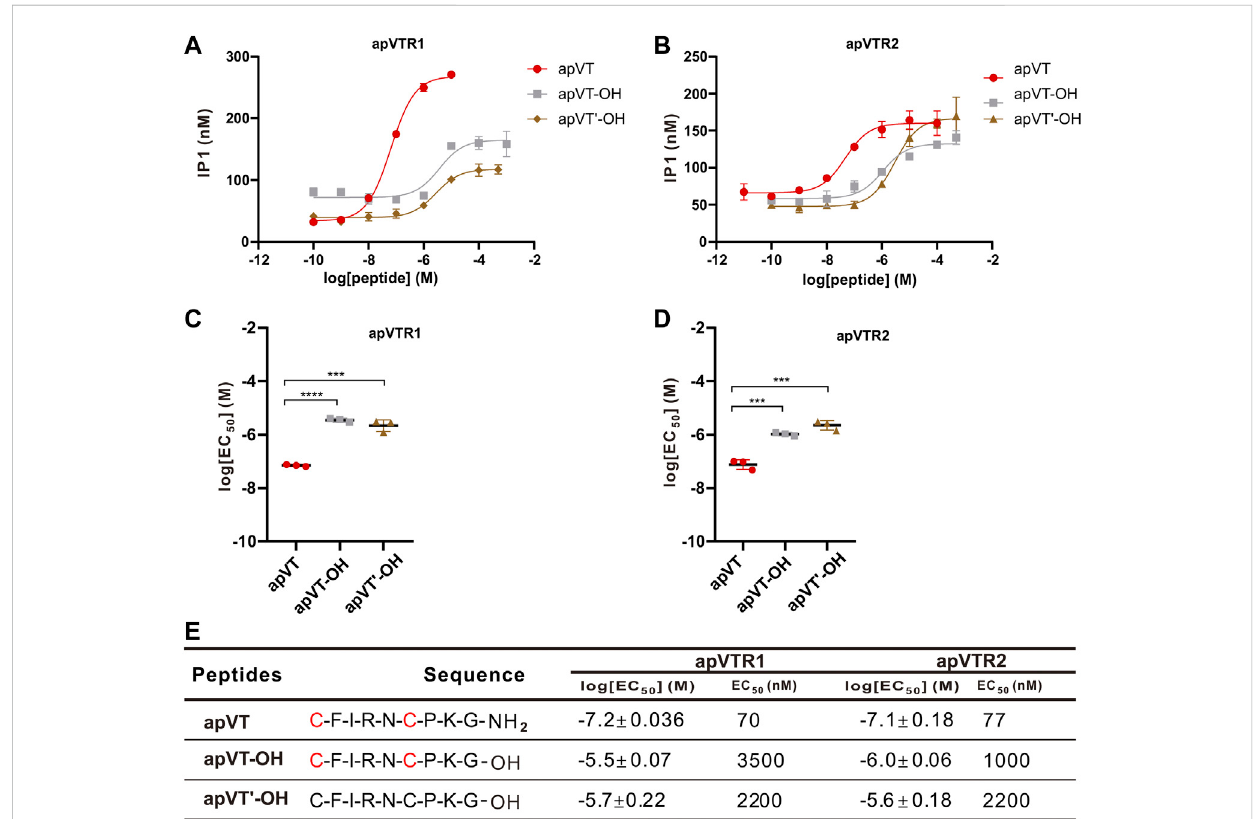
Activation of apVTRs by apVT analogs without the C-terminal amidation. (A) Representative examples of activation of apVTR1 by apVT analogs without the C-terminal amidation: apVT-OH and apVT ’ -OH; apVT was used as a control. (B) Activation of apVTR2 by apVT without the C-terminal amidation:apVT-OHandapVT ’ -OH;apVTwasusedascontrol. (C) Comparisonoflog[EC 50 ]forapVTR1byapVTandthetwoapVTanalogs(n=3foreach) shown in (A) . One-way ANOVA, F (2, 6) = 143.4, p < 0.0001. (D) Comparison of log[EC 50 ] for apVTR2 by apVT and the two apVT analogs ( n = 3 for each) shownin (B) .One-way ANOVA, F(2,6) =80.89, p < 0.0001.Bonferroni posthoc test:***, p < 0.001;****, p < 0.0001. (E) SequencesofapVTandall apVT analogs tested and summary of the average log[EC 50 ] and EC 50 on apVTR1 and